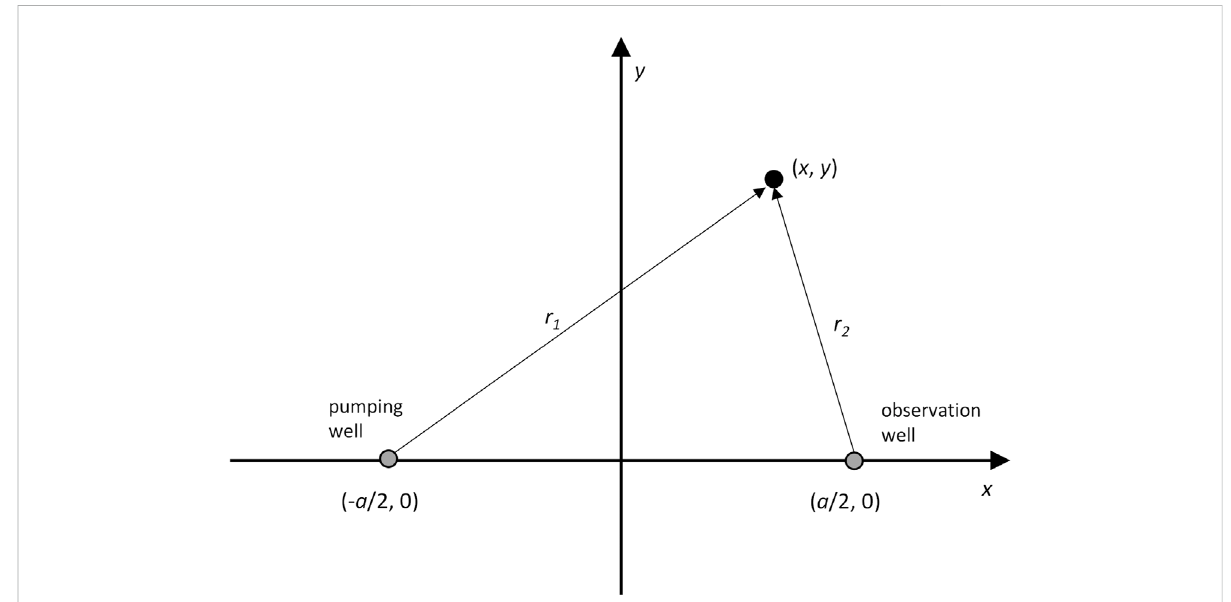
FIGURE 1 A pumping andobservation well. Also shown isageneral pointin two-dimensionalspace.The hydraulicproperties atthispoint are functions of location ( x , y